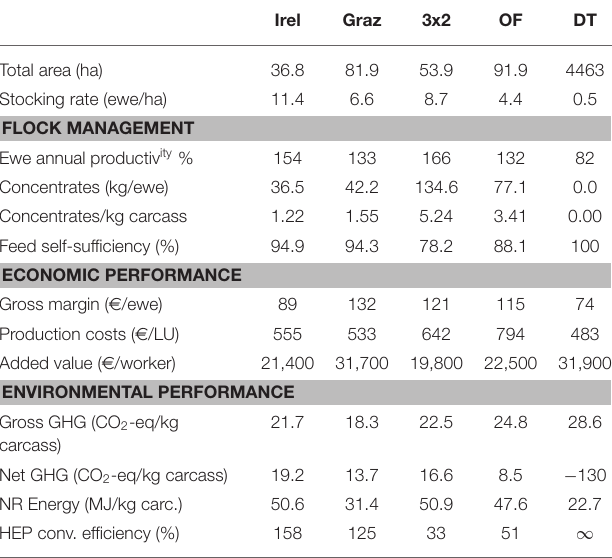
TABLE 1 | Main characteristics of the five farms, including their structure, flock management strategy, and economic and environmental performance [adapted from Benoit et al.